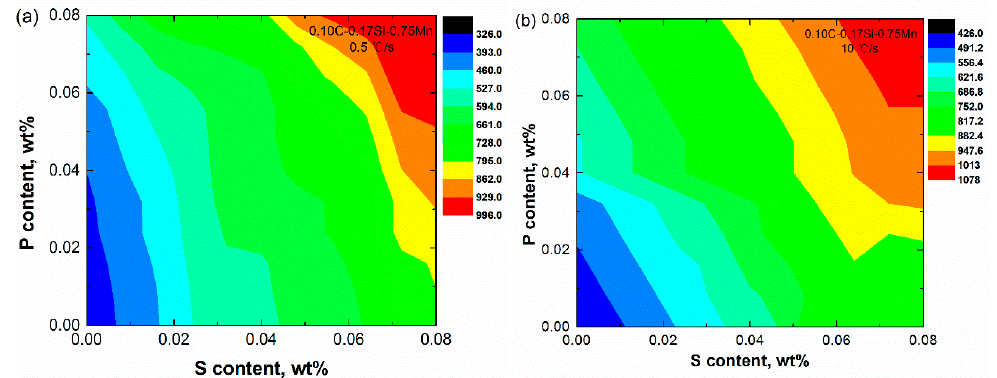
Figure 9. Crack susceptibility maps of peritectic steels with varying P and S at cooling rates of: ( a ) 0.5 ◦ C / s, ( b ) 10 ◦ C / s.